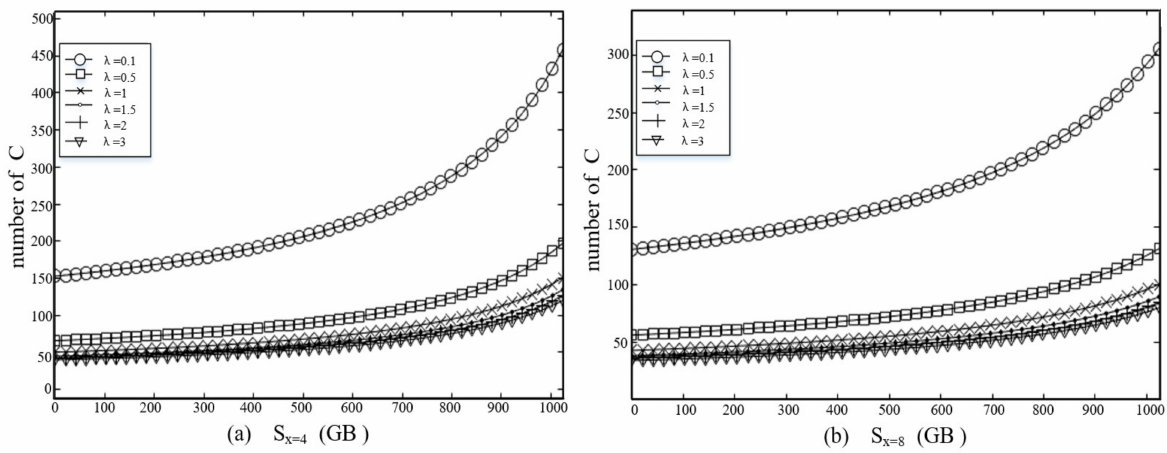
Figure 11. Intelligent scheduling in linear networking.